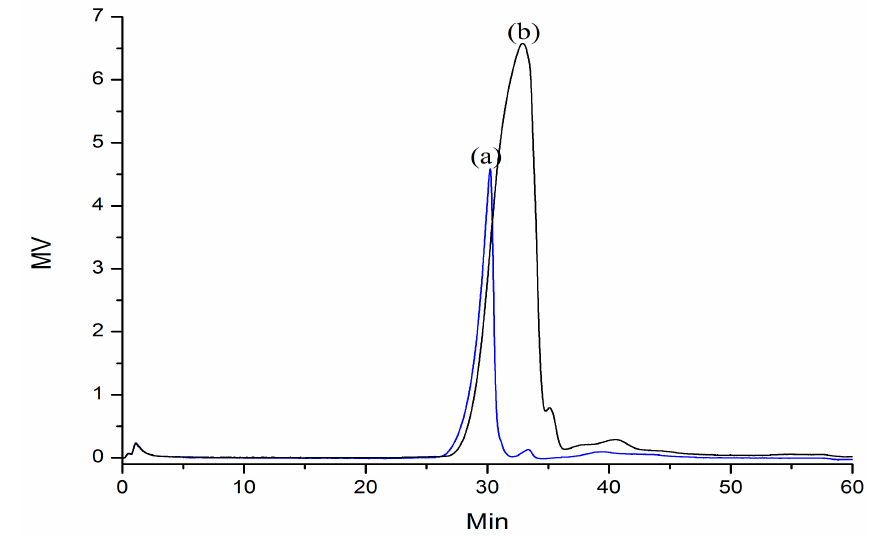
Figure 1. Elution profile of AGP33 ( a ) and its hydrolysis product BAGP33 ( b ) on SEC chromatography using a differential refraction detector.